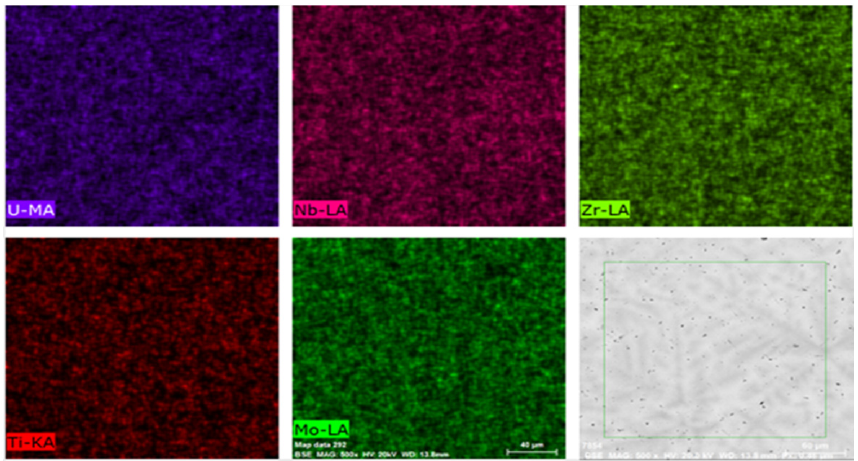
Figure 12. EDS map of the UNb 0.5 Zr 0.5 Ti 0.2 Mo 0.2 alloy. Table 9. Hardness and strength of the UNb 0.5 Zr 0.5 Ti x Mo x HEAs.